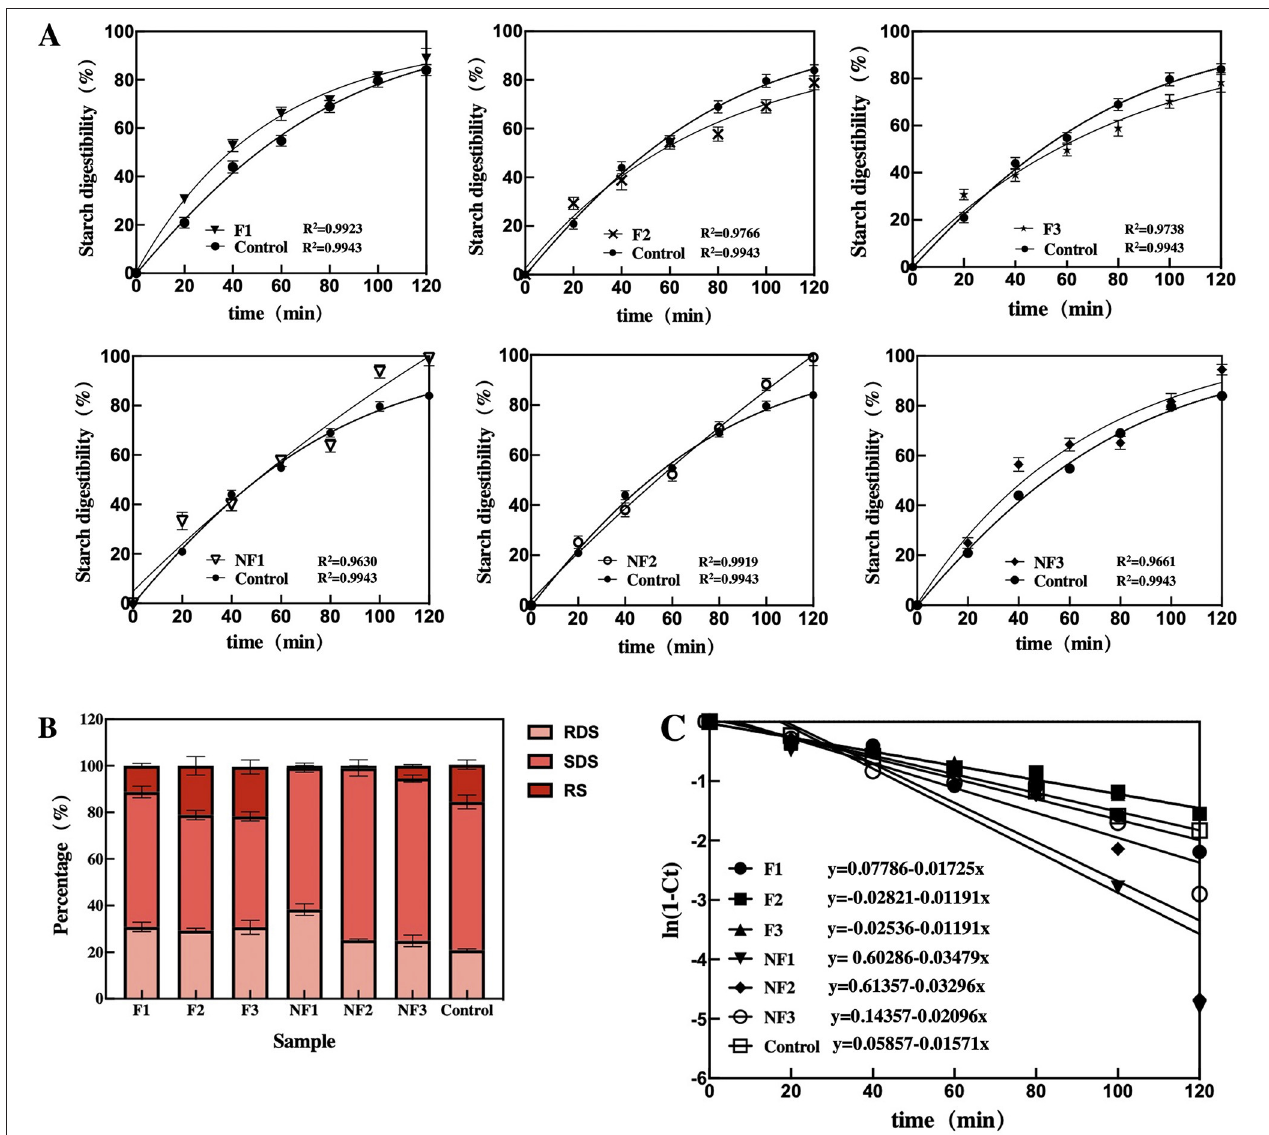
FIGURE 2 | In vitro starch digestion of fried and non-fried instant noodle products. (A) Digestograms and the fit of first-order kinetics; (B) starch fractions (C) kinetic constants of instant noodle